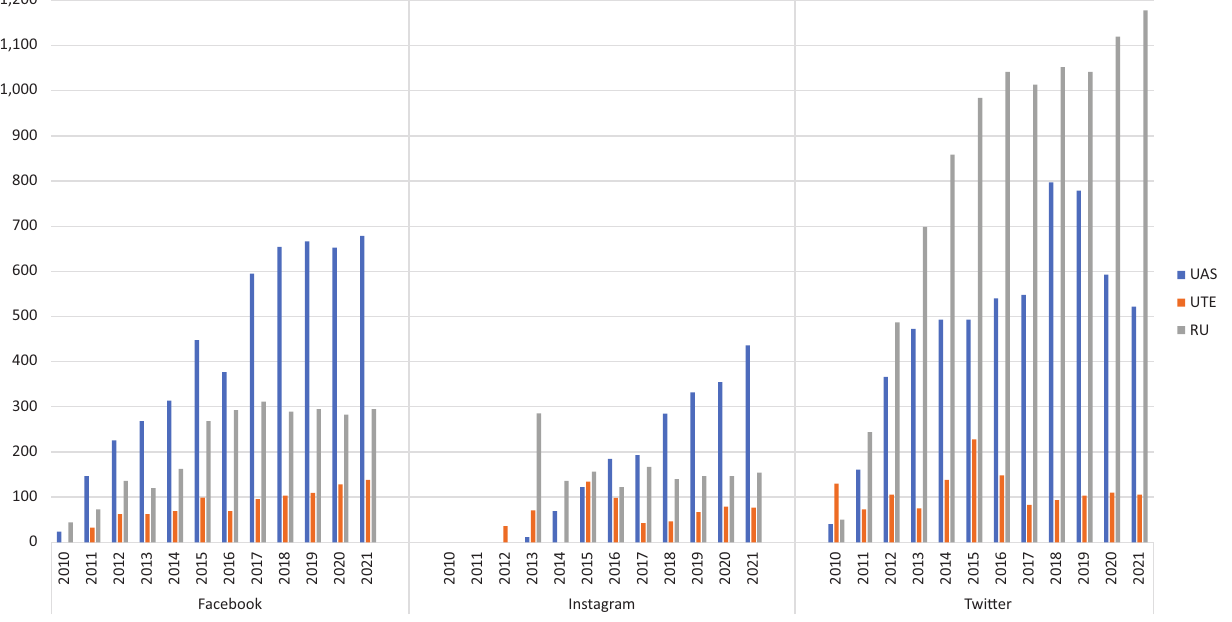
Figure 2. Yearly average number of published posts by HEI type on Twitter, Facebook, and Instagram. Notes: UAS =